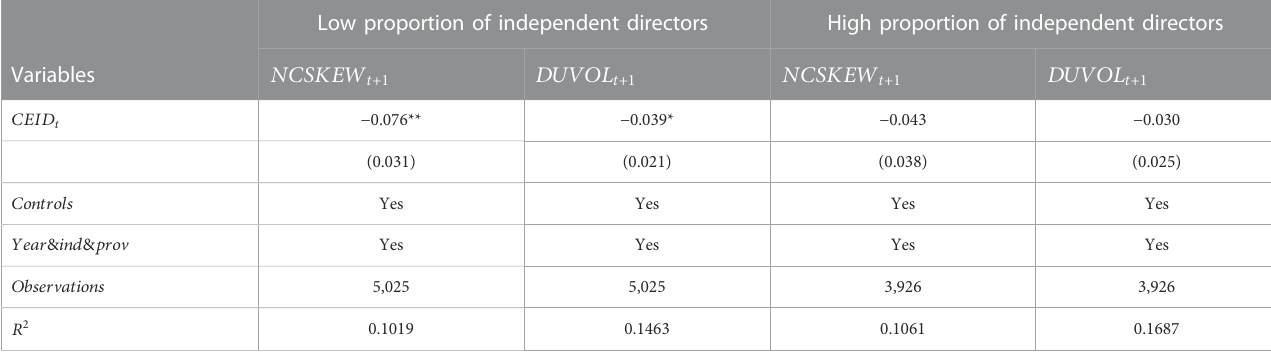
TABLE 8 Environmental information disclosure and board